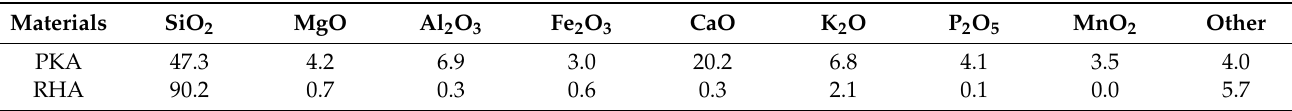
Table 4. Chemical composition of reinforcements (PKA and